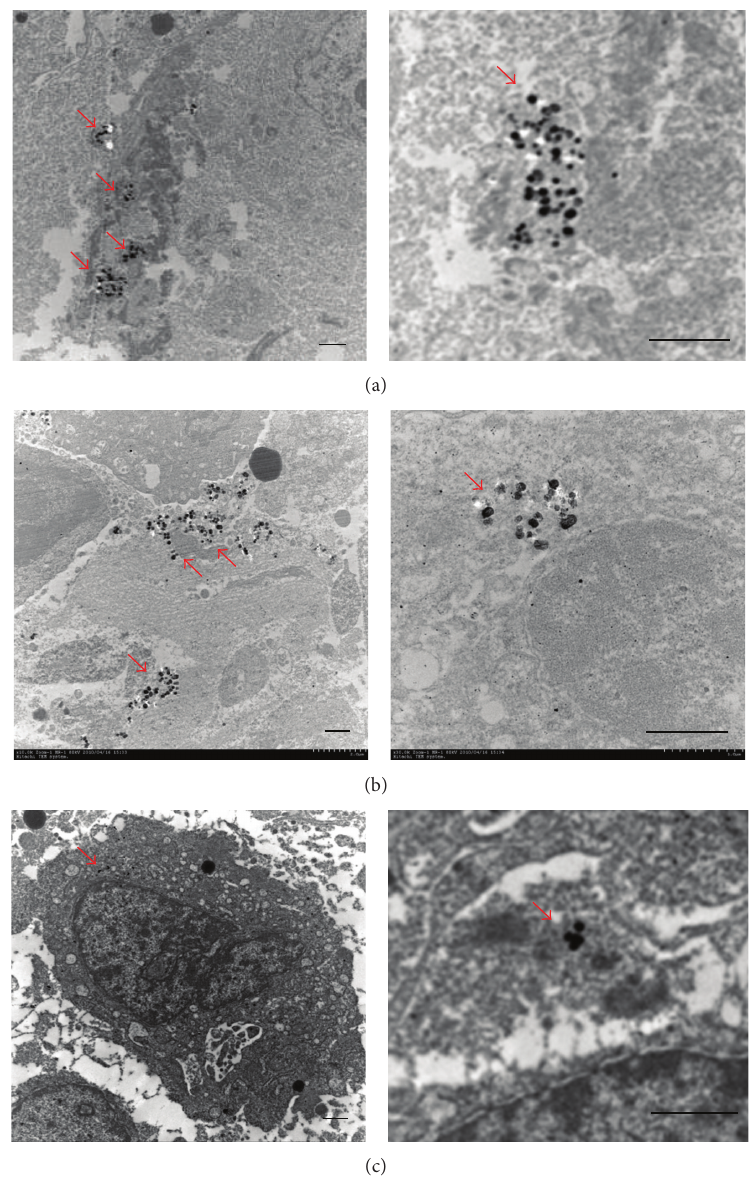
Figure 7: TEM images of tissue sections of tumors harvested at (a) 0h, (b) 1 h, and (c) 6 h following intratumoral injection of MSN-PdTPP nanoparticles. Red arrows indicate MSN-PdTPP nanoparticle accumulations (scale bars: 1 𝜇